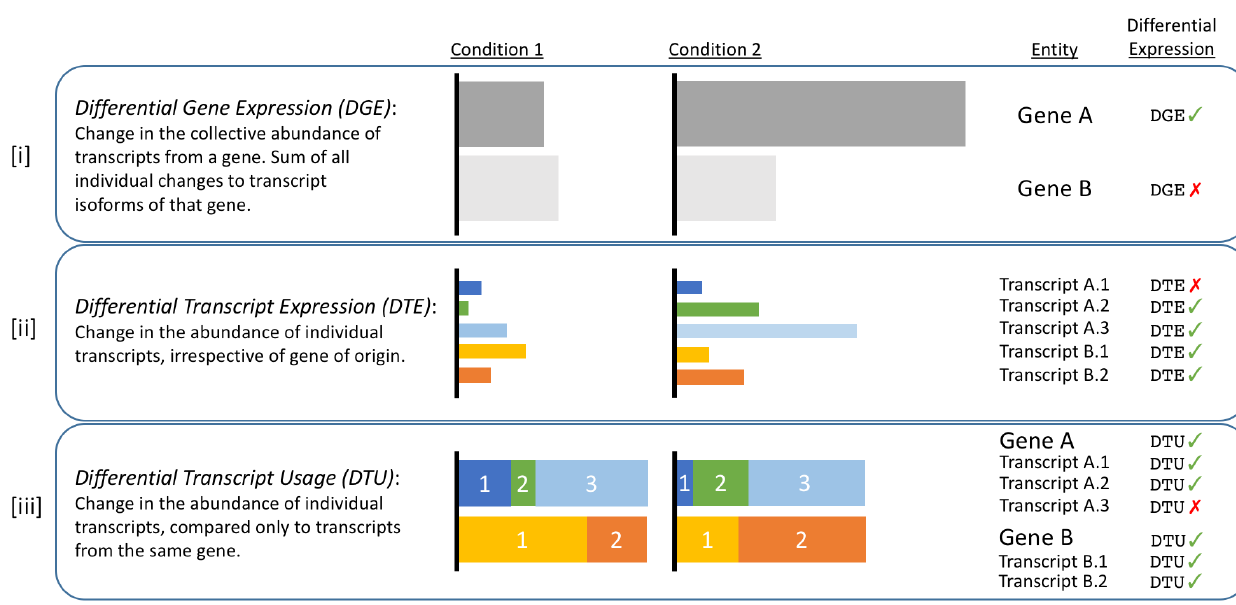
Figure 1. Illustrative definitions of the three types of differential expression analysis (DGE, DTE and DTU). The expression of two genes (Gene A and Gene B), with 3 and 2 isoforms respectively, is compared across two conditions (Condition 1 and Condition 2). The horizontal width of each coloured box represents the abundance of the relevant gene or transcript. A negative differential expression result (red cross-mark) for a given entity in any one of the three analysis types does not exclude that same entity from having a positive result (green tick-mark) in one of the other two analysis types. The relative isoform abundances in [ iii ] are scaled to the absolute isoform abundances in [ ii ], which in turn are scaled to the gene expressions in [ i ]. Gene A is differentially expressed, but only two of its three isoforms are differentially expressed (A.2 and A.3). Proportionally, Gene A’s primary isoform (A.3) remains the same, but the ratios of the two less abundant isoforms change. Gene B is not differentially expressed, but both its isoforms are differentially expressed, and demonstrate an example of isoform switching. DGE: Differential gene expression, DTE: Differential transcript expression, DTU: Differential transcript